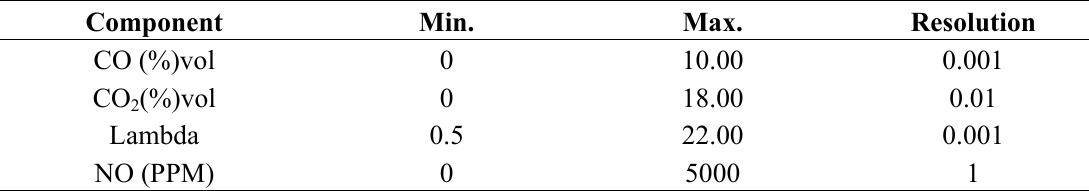
Table 1. The gas analyser ranges, accuracy and